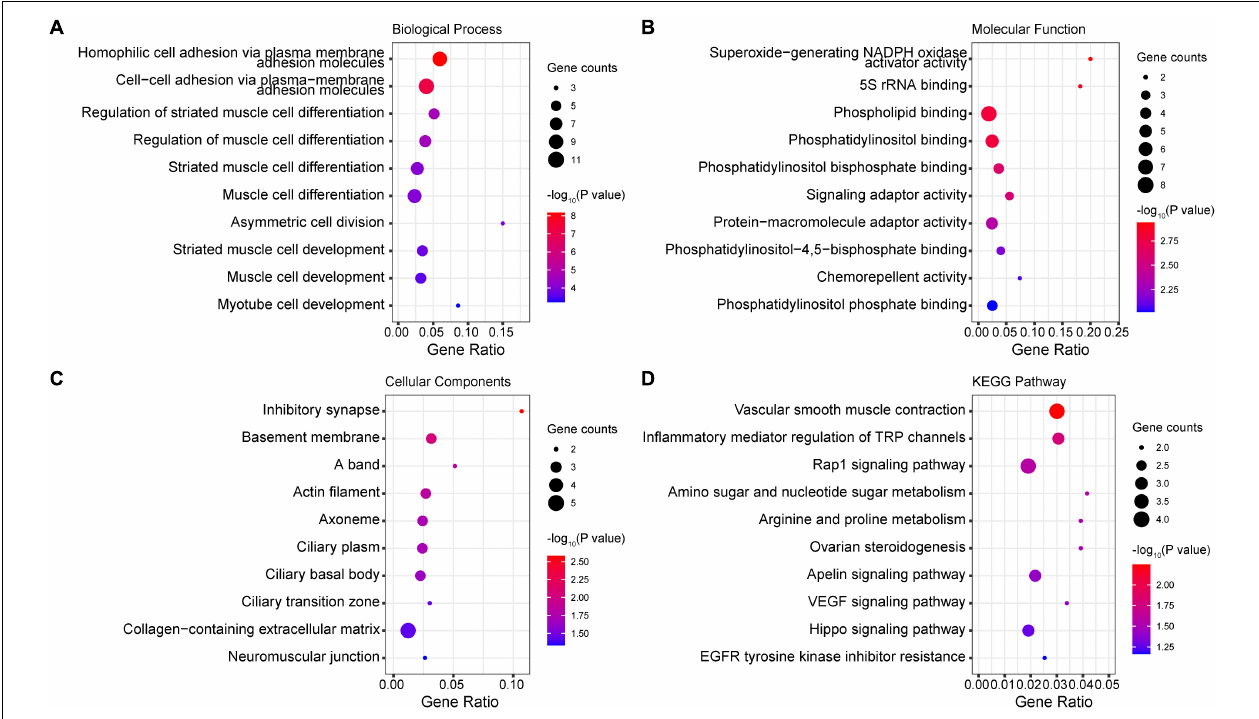
FIGURE 3 | Enrichment of DMP genes in GO terms and KEGG pathways. (A) Top enriched GO biological process terms. (B) Top enriched GO molecular function terms. (C) Top enriched GO cellular components terms. (D) Top enriched KEGG